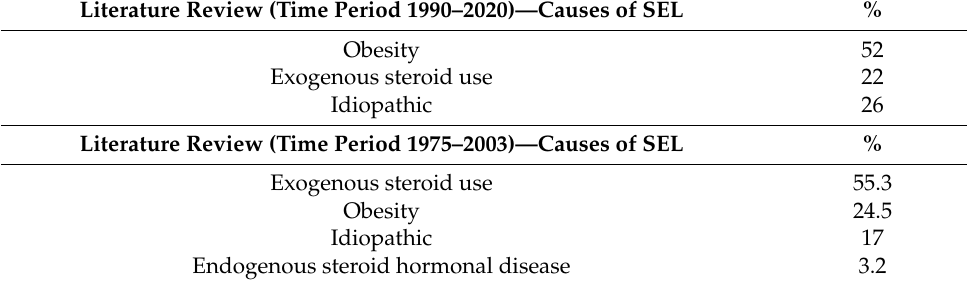
Table 1. Data of SEL etiologies from a recent systematic literature review (time period 1990–2020) by Alomari et al. [77] and from a previous systematic literature review (time period 1975–2003) by Fogel et al.